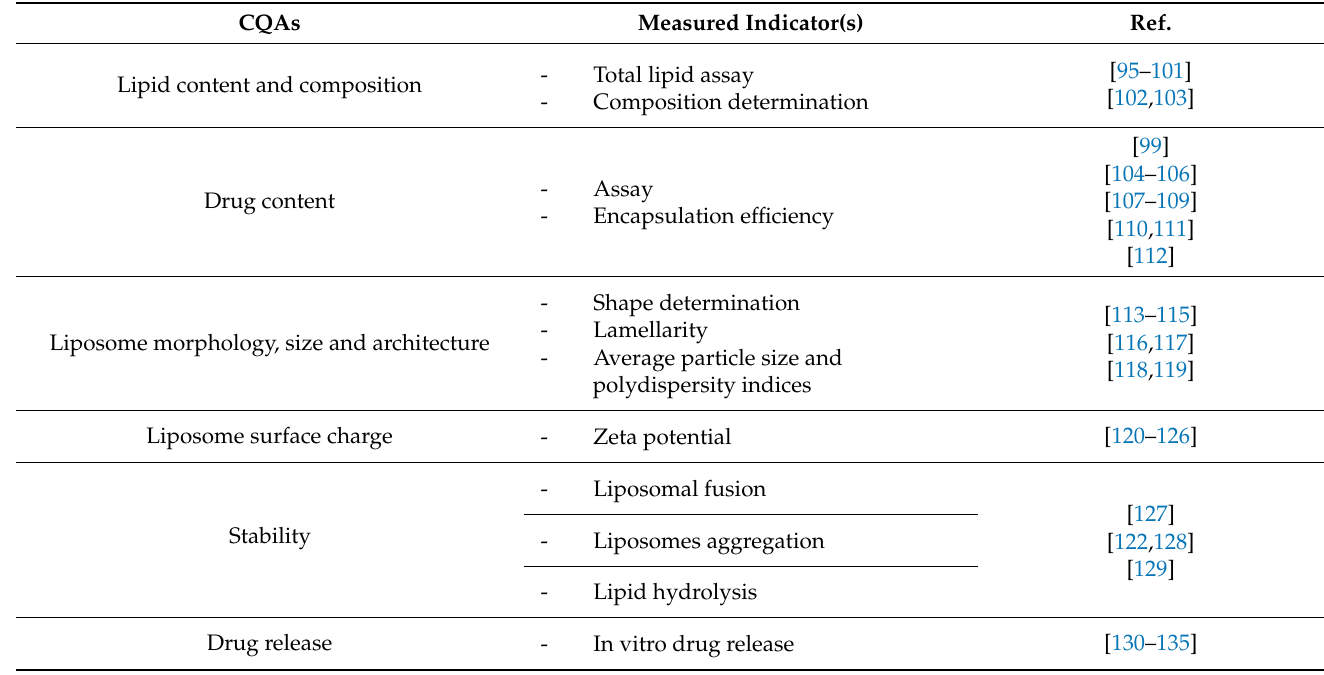
Table 3. Critical quality attributes (CQAs) needed for full liposome drug product characterization. CQAs Measured Indicator(s) Ref.